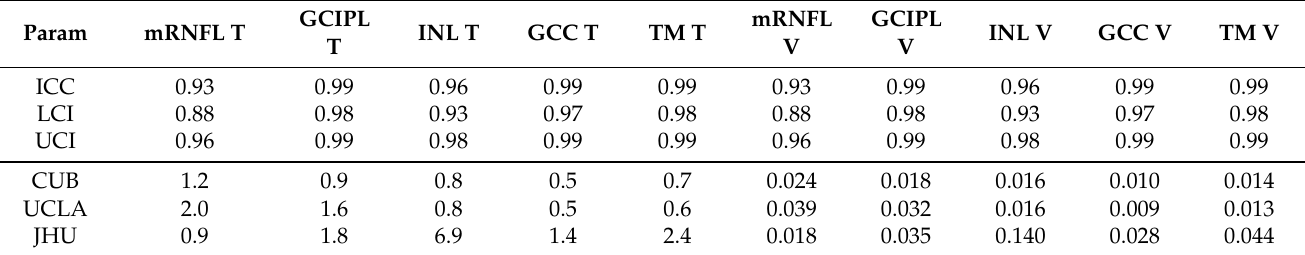
Table 8. The reliability of the standard parameters (top three rows) and fidelity of the computed parameters (MAE in µ m) from CCU-INSEG’s segmentation with respect to the manual segmentation (the last three rows). Abbreviations (The last two letters are either T or V, where T is thickness and V